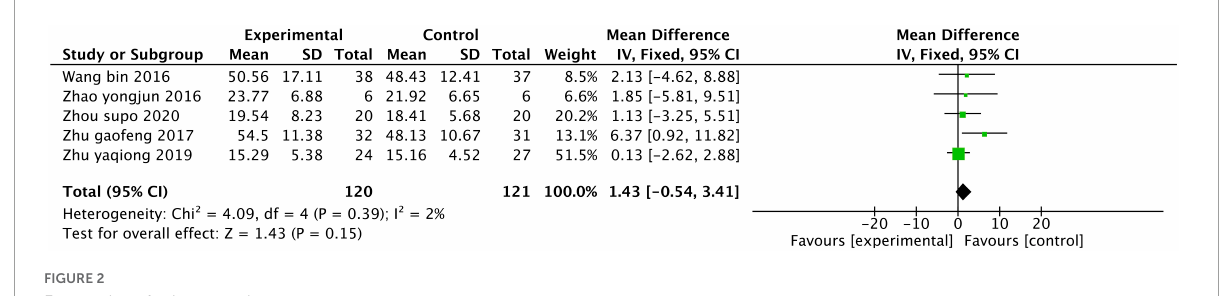
FIGURE2 Forest plot of grip strength